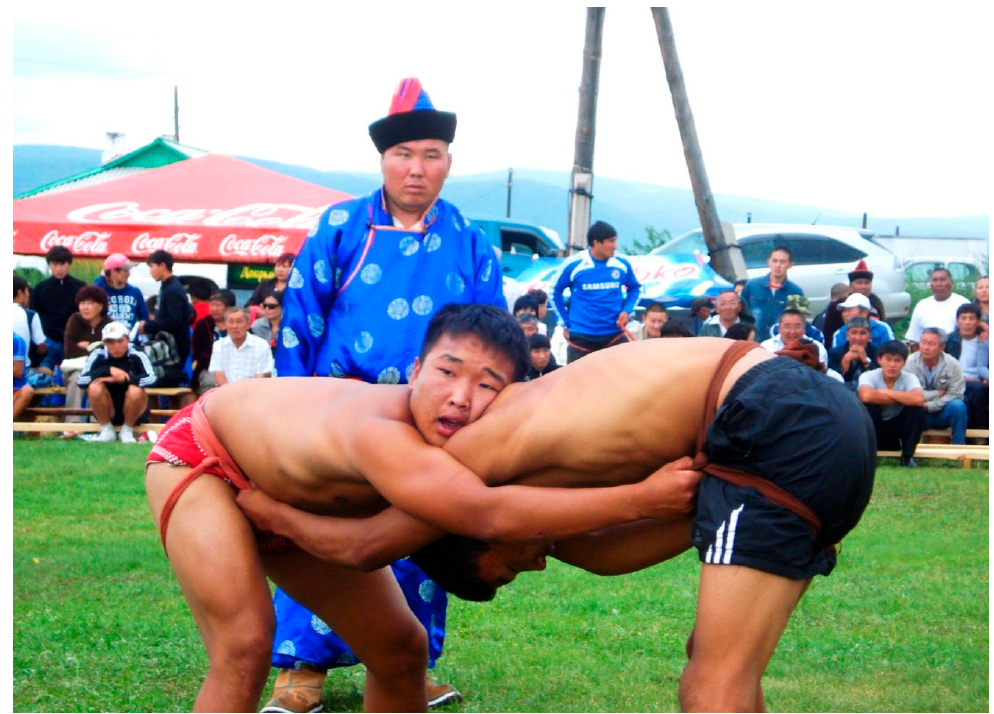
Figure 1. Buryat wrestlers in a match overseen by a referee during a tournament organized as part of the Maidar Khural celebrations at the Ivolginsk Buddhist monastery in 2010. Photo: Stefan Krist.